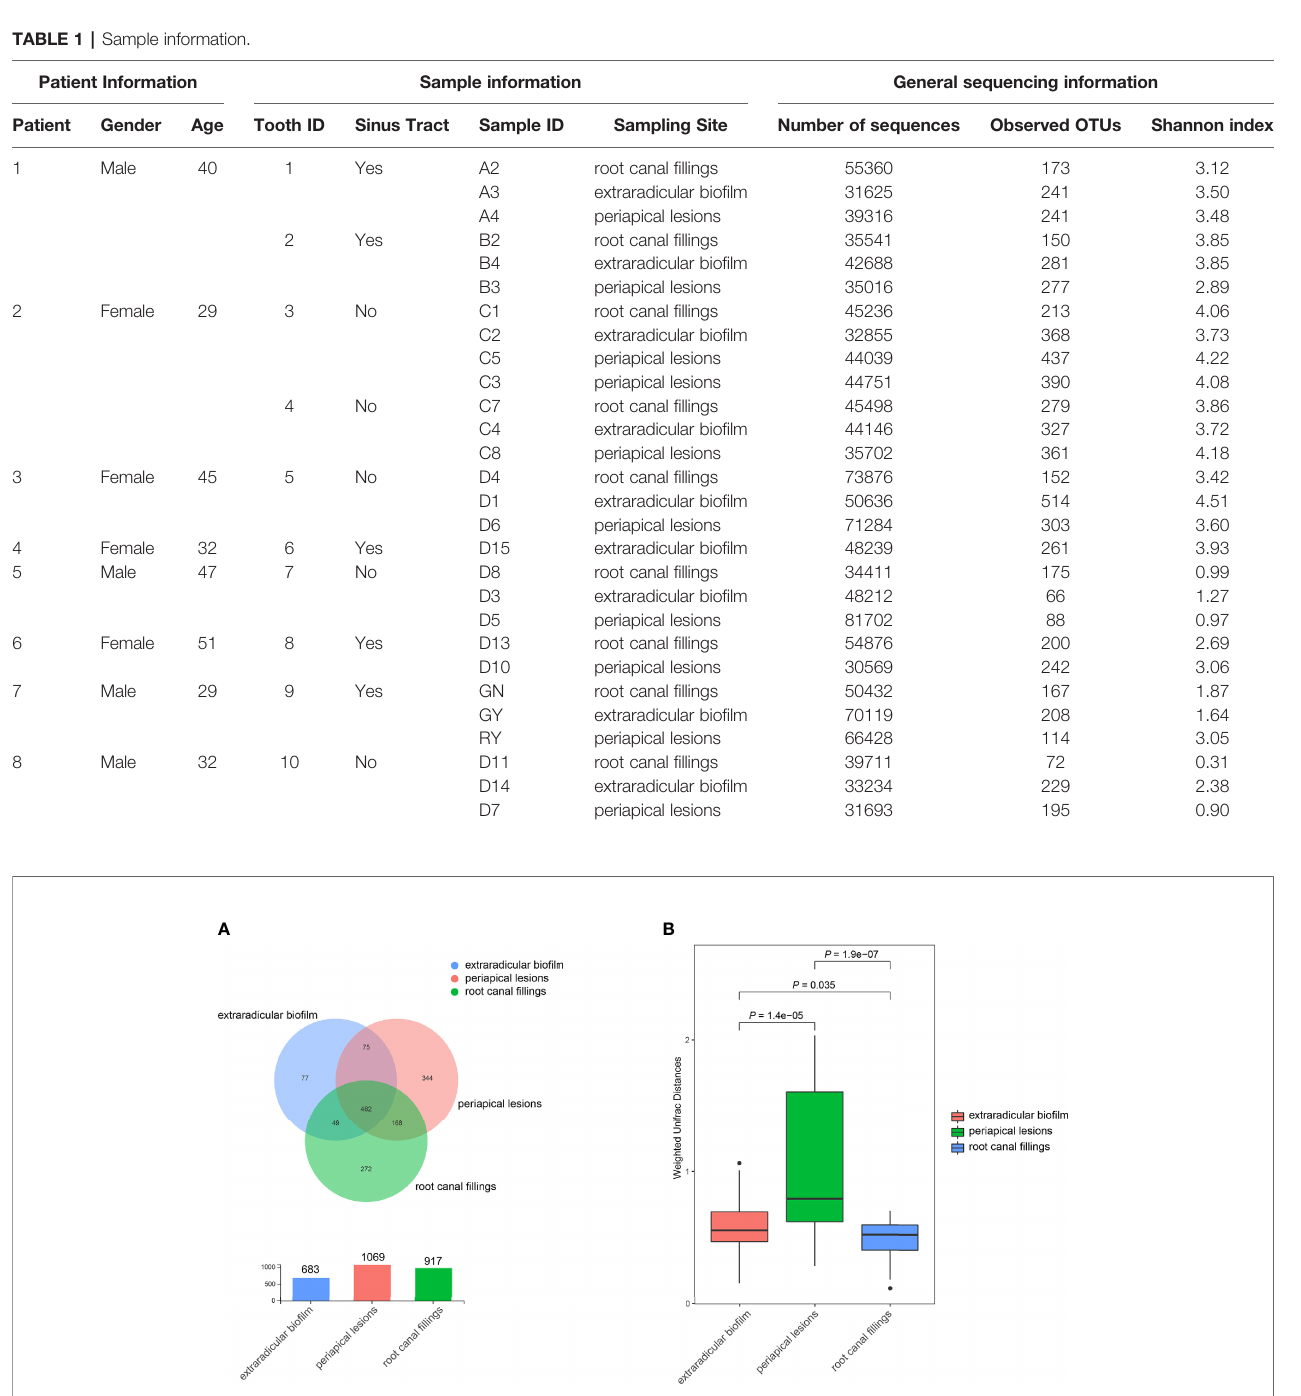
FIGURE 2 | Distribution of OTUs in samples collected from the root canal, extraradicular bio fi lm, and periapical lesions. (A) the Venn diagram indicates the shared/ unique OTUs in samples from the root canal, extraradicular bio fi lm, and periapical lesions; (B) comparison of beta-diversities between samples within each group. The P -values were calculated using the student ’ s